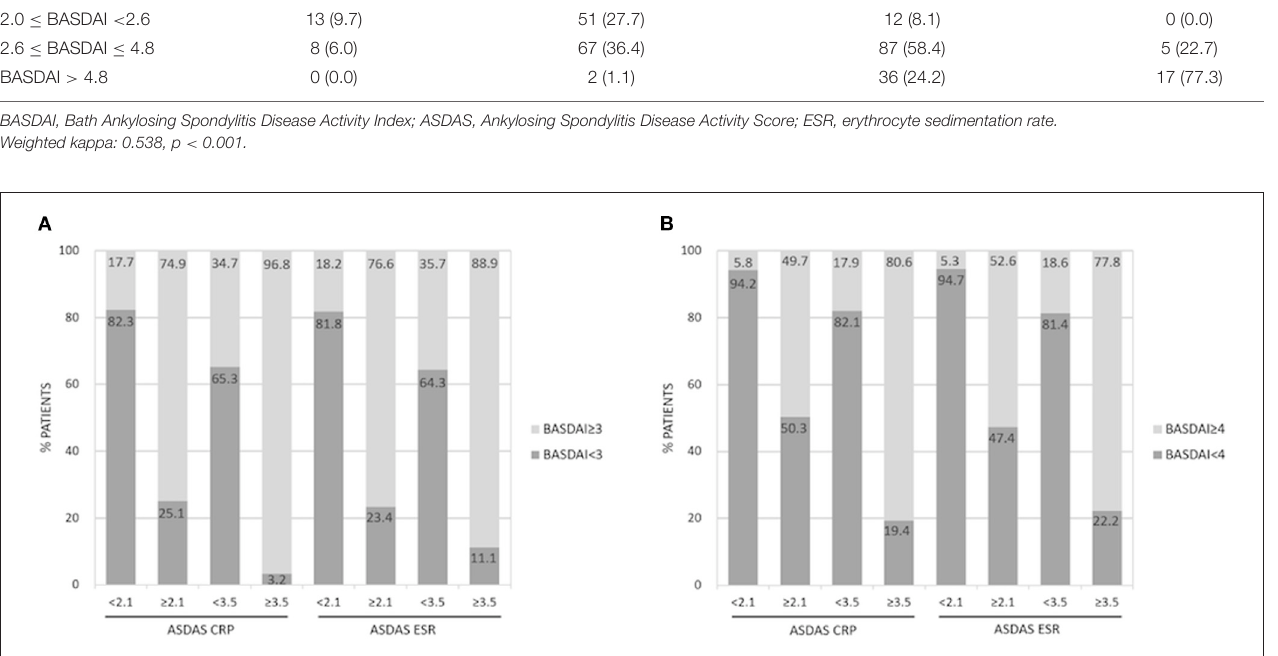
with non-radiographic axial spondyloarthritis and the inclusions of patients with a shorter symptom duration than our